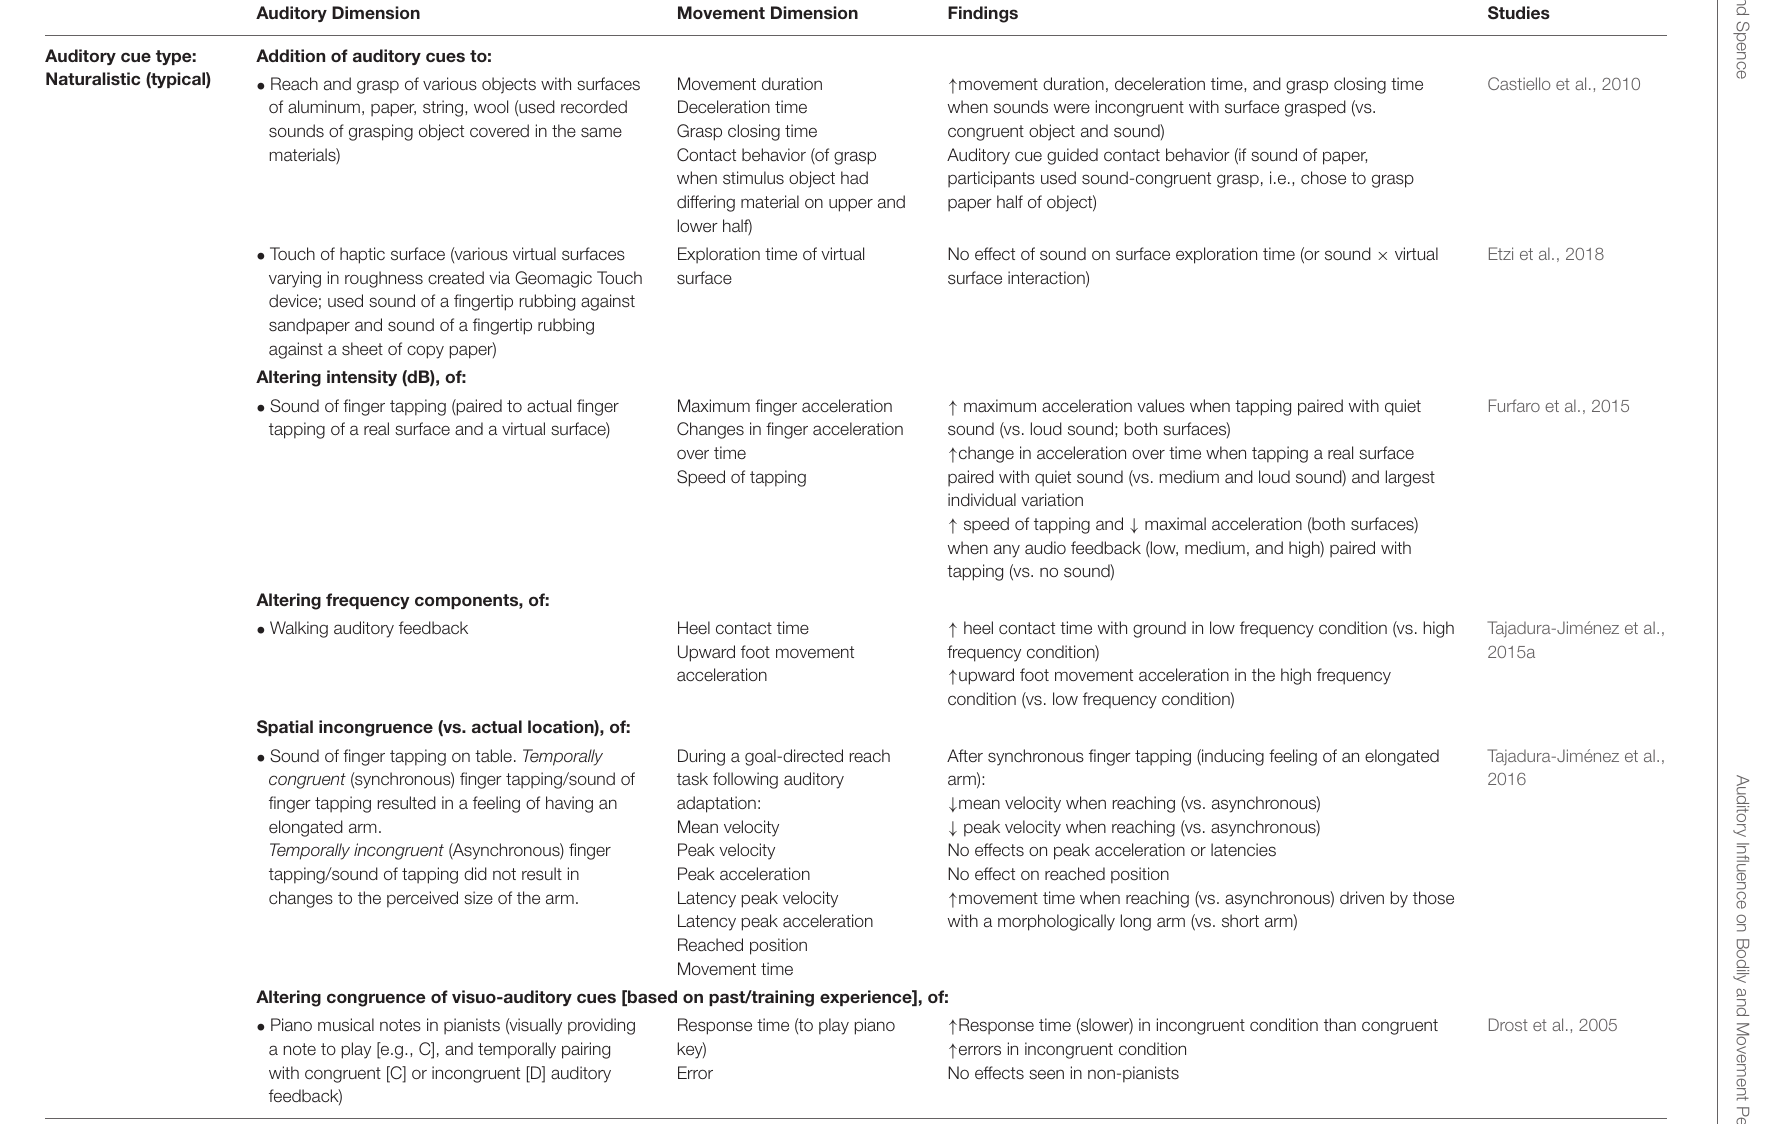
TABLE 6 | Summary of the effects of non-veridical auditory cues on motor behavior. Auditory Dimension Movement Dimension Findings Studies Auditory cue type: Naturalistic (typical) Castiello et al.,